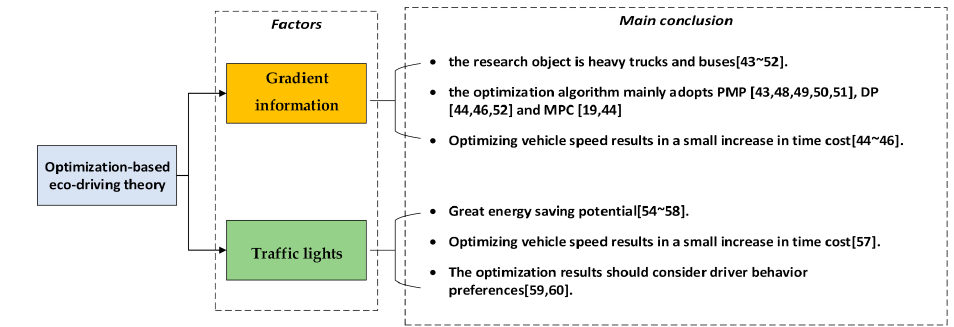
Figure 5. Main factors and conclusions of optimization-based eco-driving